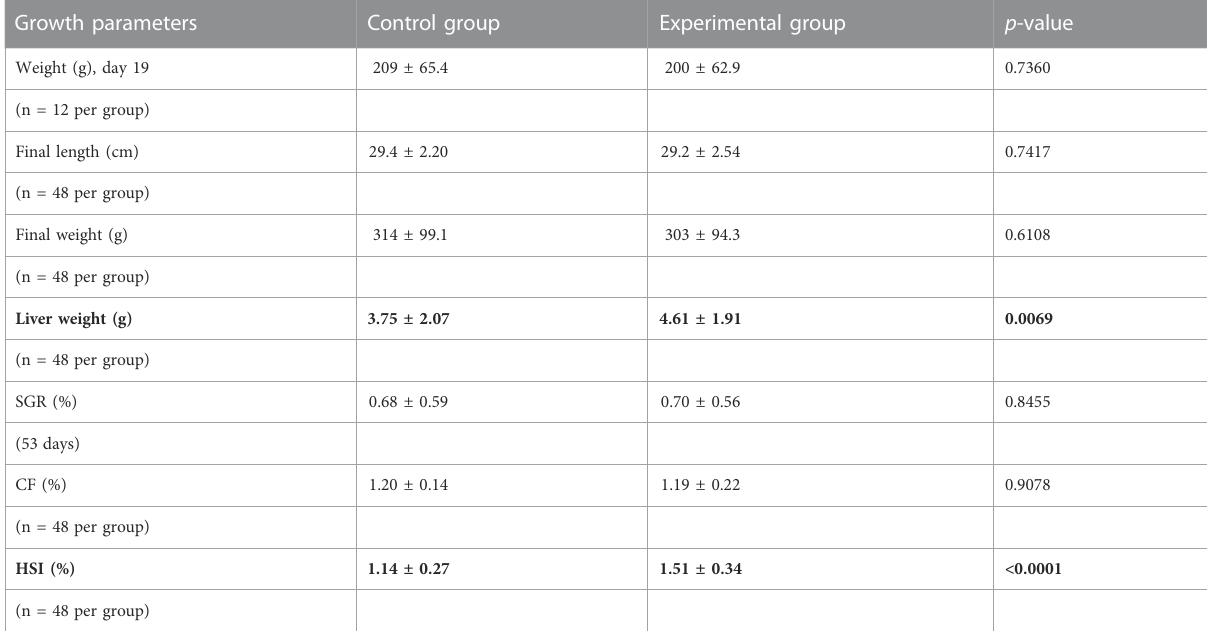
TABLE 4 Growth parameters for fi sh fed with control feed or experimental yeast-based feed. Data are presented as the mean ± standard deviation. Statistical signi fi cance was set at p -value < 0.05. Growth